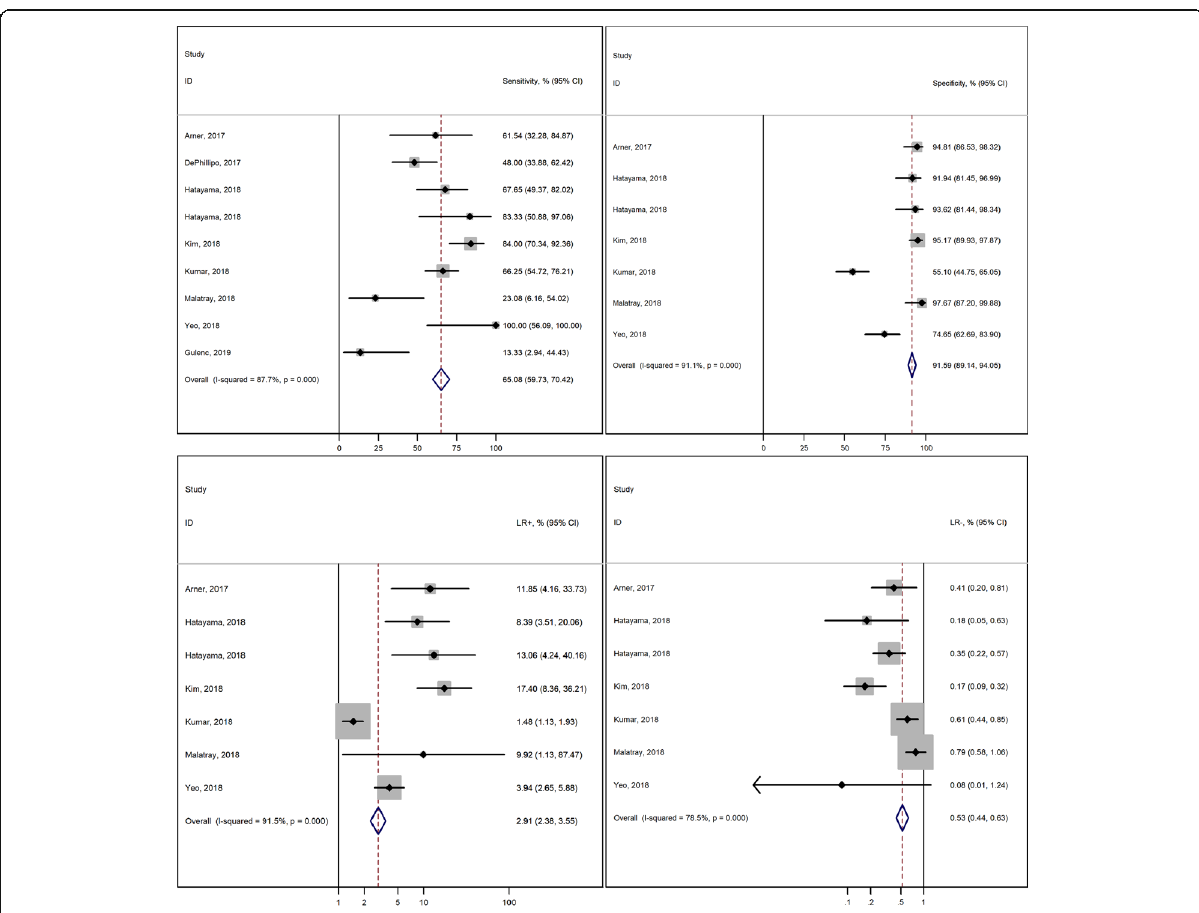
Fig. 3 Forest plots summarizing MRI accuracy in the detection of ramp lesions. Dots in squares represent the estimated measures while the horizontal lines represent the 95% CI. The diamond shape represents the combined estimate. I 2 with 95% CI and the result of the using the chi-squared test are also provided. Hatayama et al. [32] used 2 different cohorts to compare different magnet strengths, 3-Tesla (upper) and 1,5-Tesla